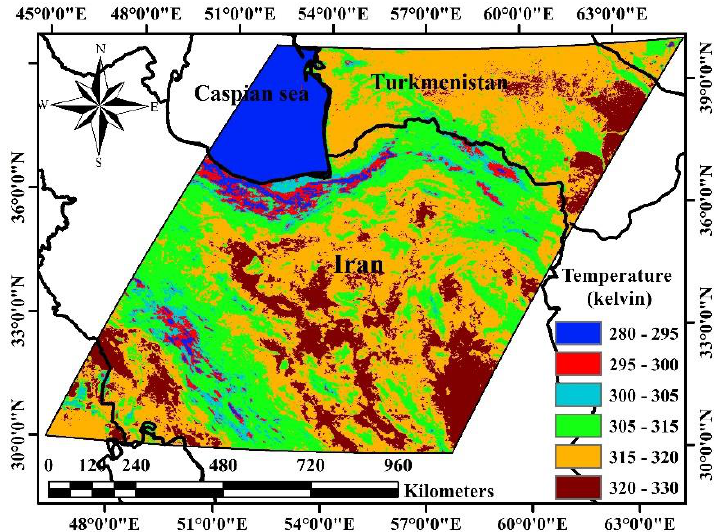
Figure 1. A land surface temperature (LST) image of the studied region .